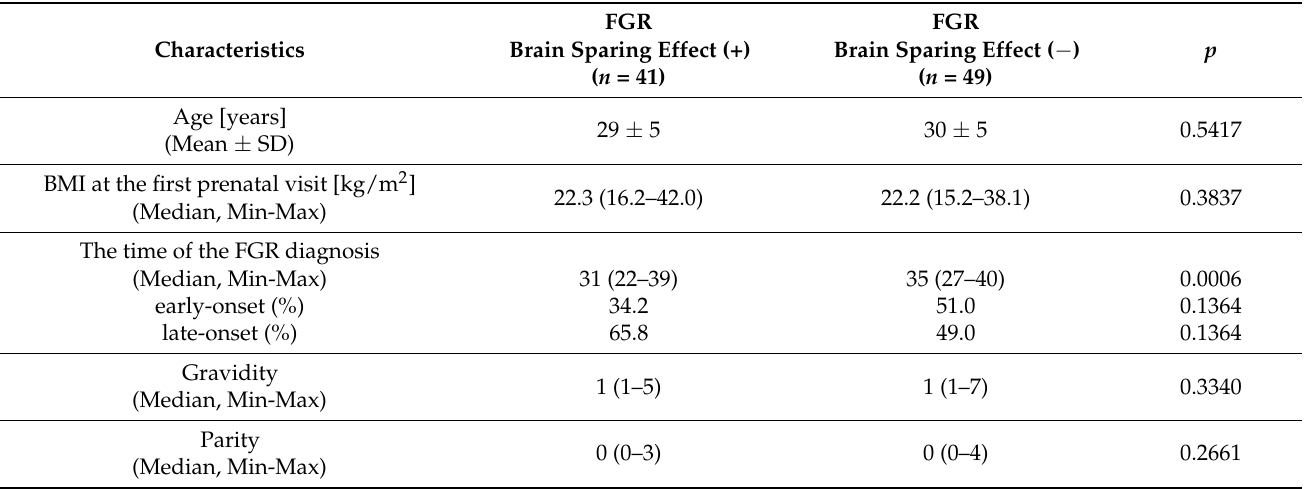
of the brain sparing